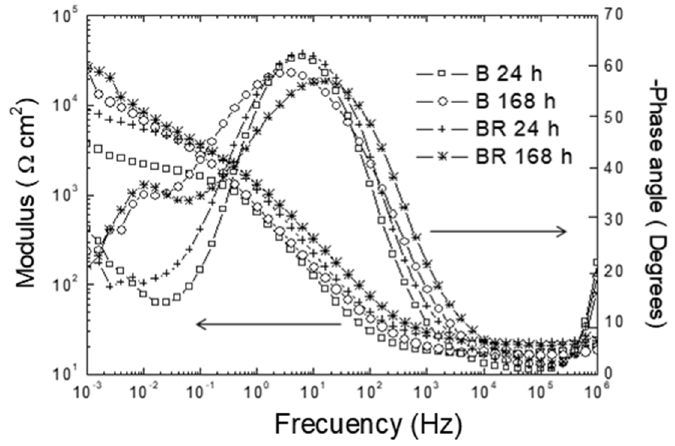
Figure 12. Bode diagrams for B (as-cast) and BR (annealed) samples after different times of exposure to 3.5 wt.% NaCl solution.